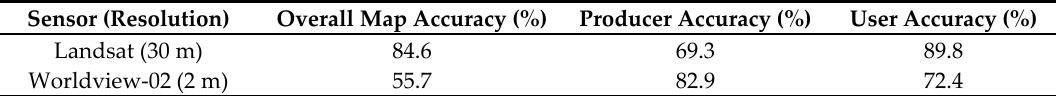
Table 5. Area-weighted error comparison for Landsat and Worldview-2 overall error, and producer (omission) and user (commission) accuracies for the mangrove